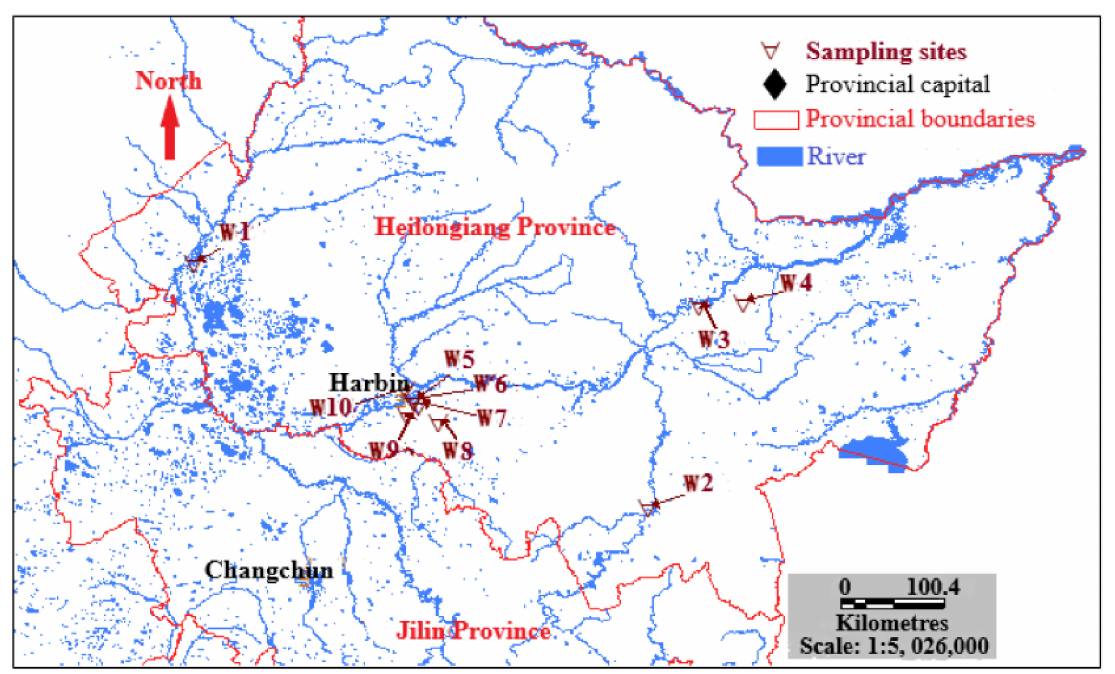
Figure 1. Sampling locations for 10 wastewater treatment plants in the Songhua River Basin, Northeast